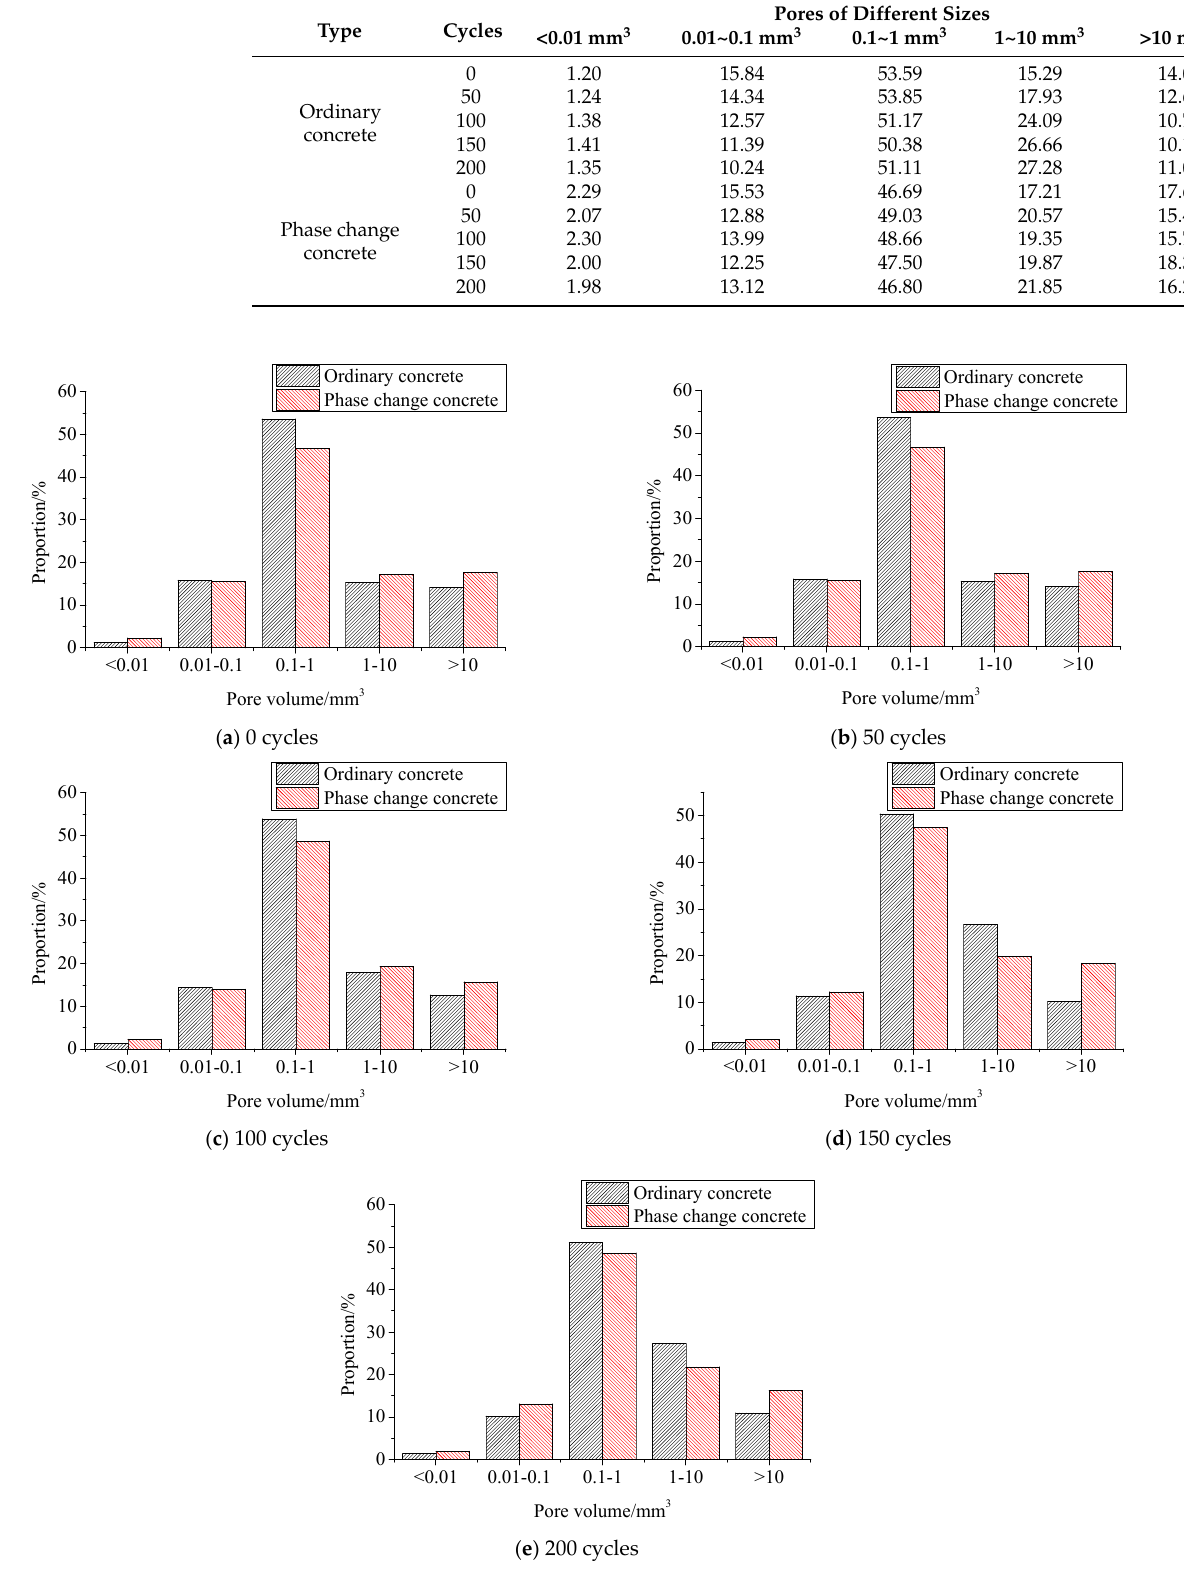
Figure 11. Comparison of pore volume ratio between ordinary concrete and phase change concrete under different freeze–thaw cycles.